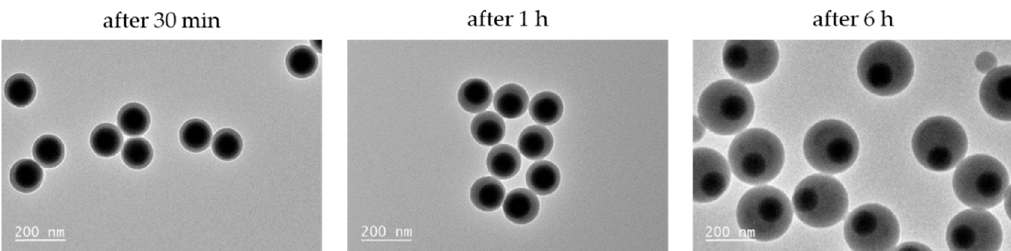
Figure 4. TEM images showing the evolution with time of the morphology of the silica/PS monopods obtained from silica seeds with d MPS = 0.6 funct./nm 2 . Experimental conditions: [100-nm silica] = 7.3 × 10 15 part./L; [styrene] = 89 g/L; [Synperonic ® NP30] = 2.85 g/L; [SDS] = 0.15 g/L; [Na 2 S 2 O 8 ] = 0.46 g/L and 70 °C. Before observation, the free PS particles were removed by one centrifugation/redispersion cycle in ethanol (2000 g; 15 min).